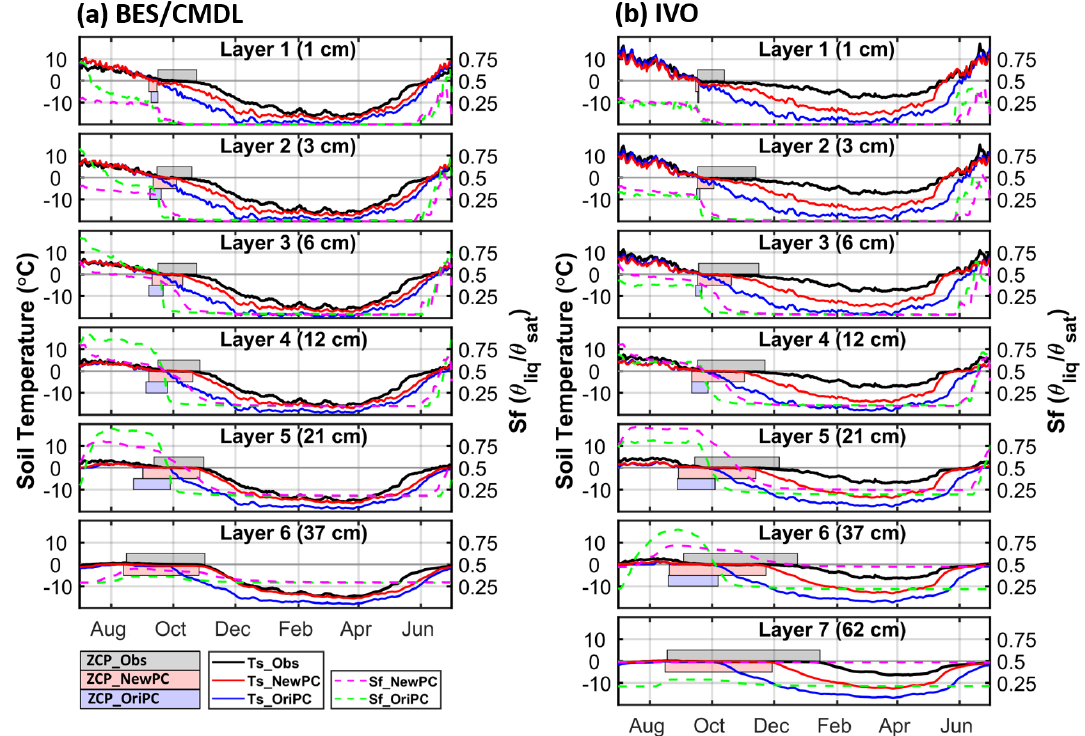
Figure 2. Comparison of multi-year (2013–2017) averaged daily soil temperatures observed (Ts_Obs, black) and simulated with the original (Ts_OriPC, blue) and improved (Ts_NewPC, red) phase-change schemes at BES/CMDL (a) and IVO (b) . Simulated moisture saturation with the original (Sf_OriPC; green) and improved (Sf_NewPC; magenta) schemes is shown on the right y axes. Here, the moisture saturation means soil unfrozen (liquid) water content. The horizontal axes indicate days from July to June, with ticks representing the first day of each month. Shaded areas represent durations of zero-curtain periods observed (ZCP_Obs, gray) and simulated (ZCP_OriPC, blue; ZCP_NewPC, red). No baseline ZCP is shown in the sixth layer for BES/CMDL and the seventh layer for IVO because the maximum annual temperature is below 0 ◦ C.